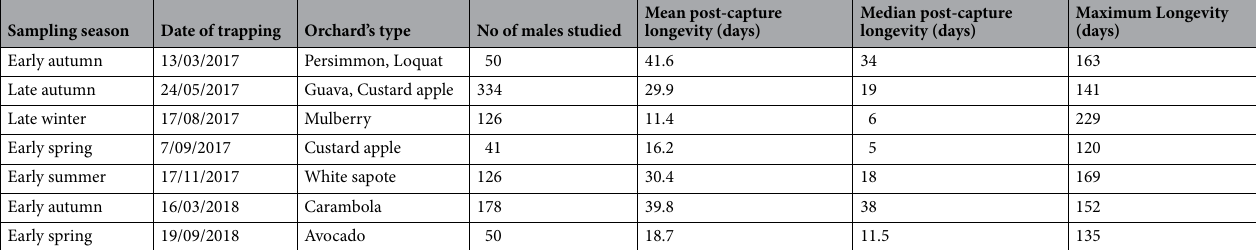
Table 2. Survival of wild Bactrocera tryoni males (= captive cohorts) in the laboratory. Flies were collected as adults during different seasons in 2017–18 from a site in subtropical Australia. In the laboratory flies were held at 27 °C constant temperature and had ad libitum access to water and